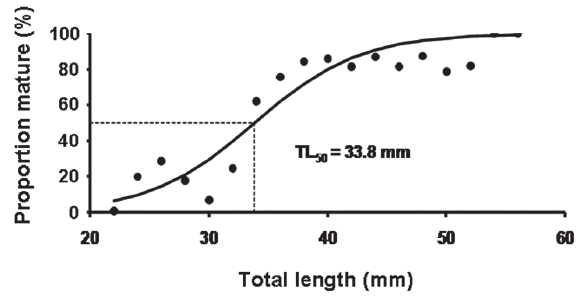
Fig . 6. – Logistic function fitting the proportion of mature Palaemon elegans females to total length (mm). TL